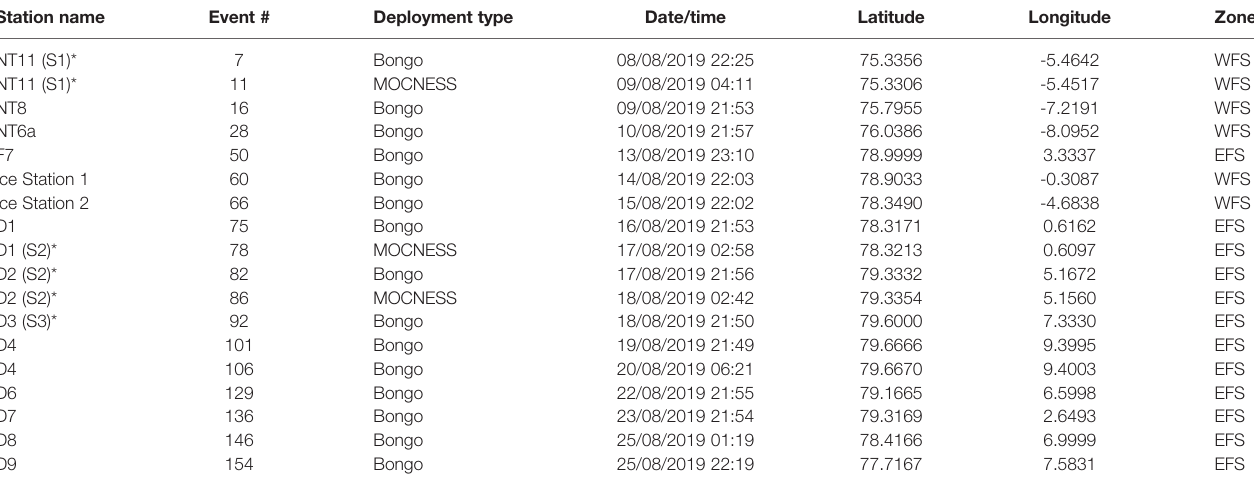
TABLE 1 | Details of net sampling deployments during cruise JR18007 to the Fram Strait by RRS James Clark Ross . Station